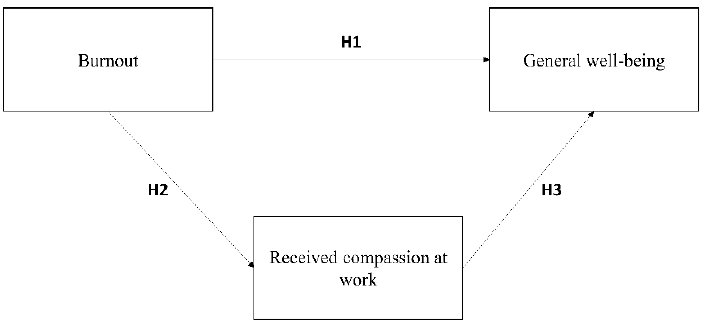
Figure 1. Theoretical model. Note. H3 refers to the mediating effect of compassion in the link between burnout and general well-being.